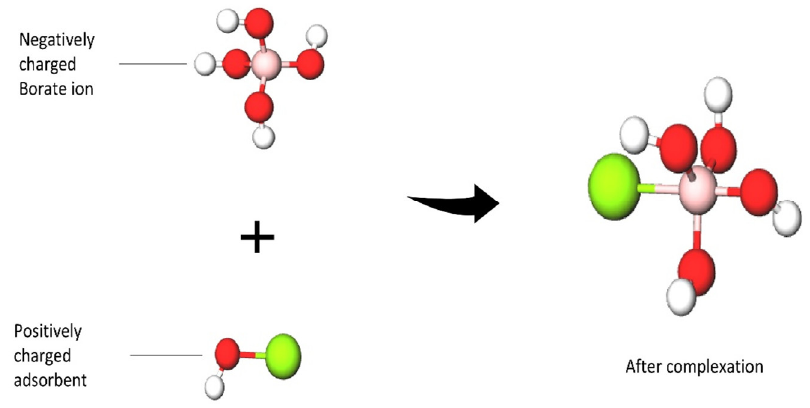
Figure 8. Illustration of the view of the structure after the complexation reaction.